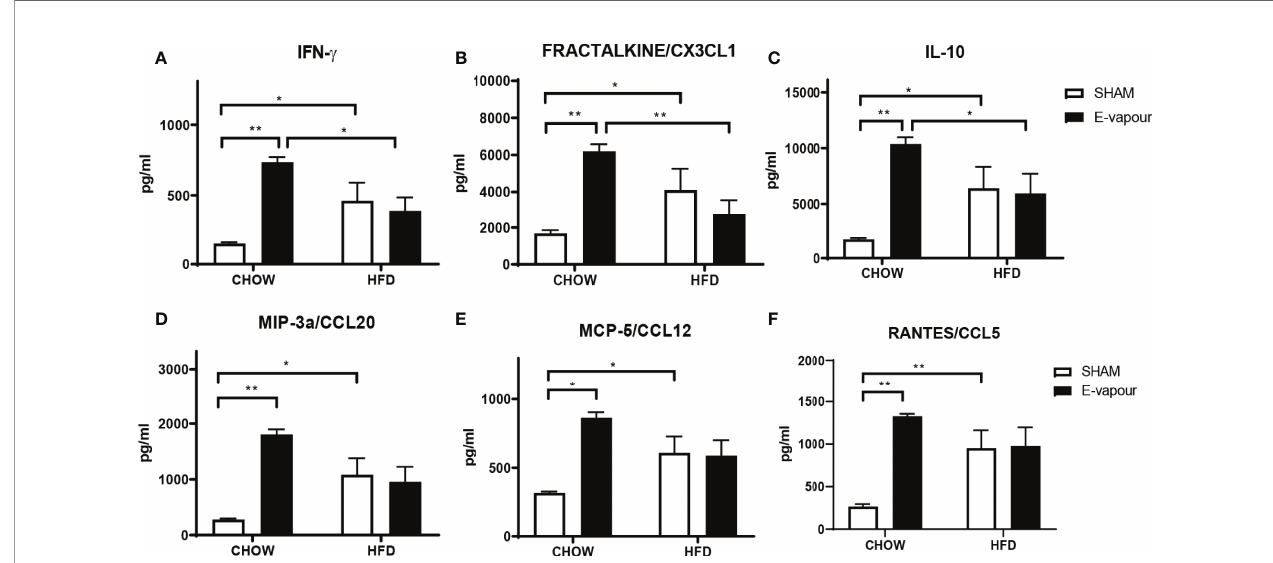
FIGURE 1 | Serum levels of cytokines IFN- g (A) , FRACTALKINE/CX3CL1 (B) , IL-10 (C) , MIP-3a/CCL20 (D) , MCP-5/CCL12 (E) , and RANTES/CCL5 (F) . Results are expressed as mean ± SEM, n = 5. *P < 0.05, **P <